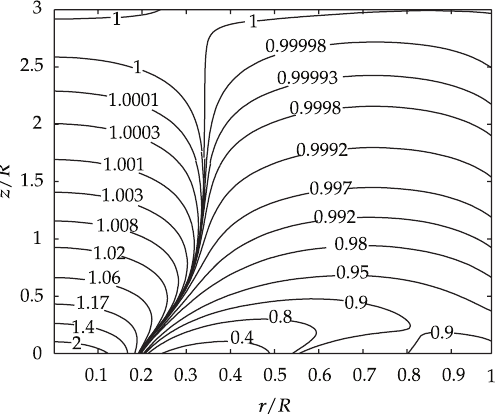
Figure 3: Distribution of the stress σ z / (cid:6) σ 0 (cid:7) in the end condition example.